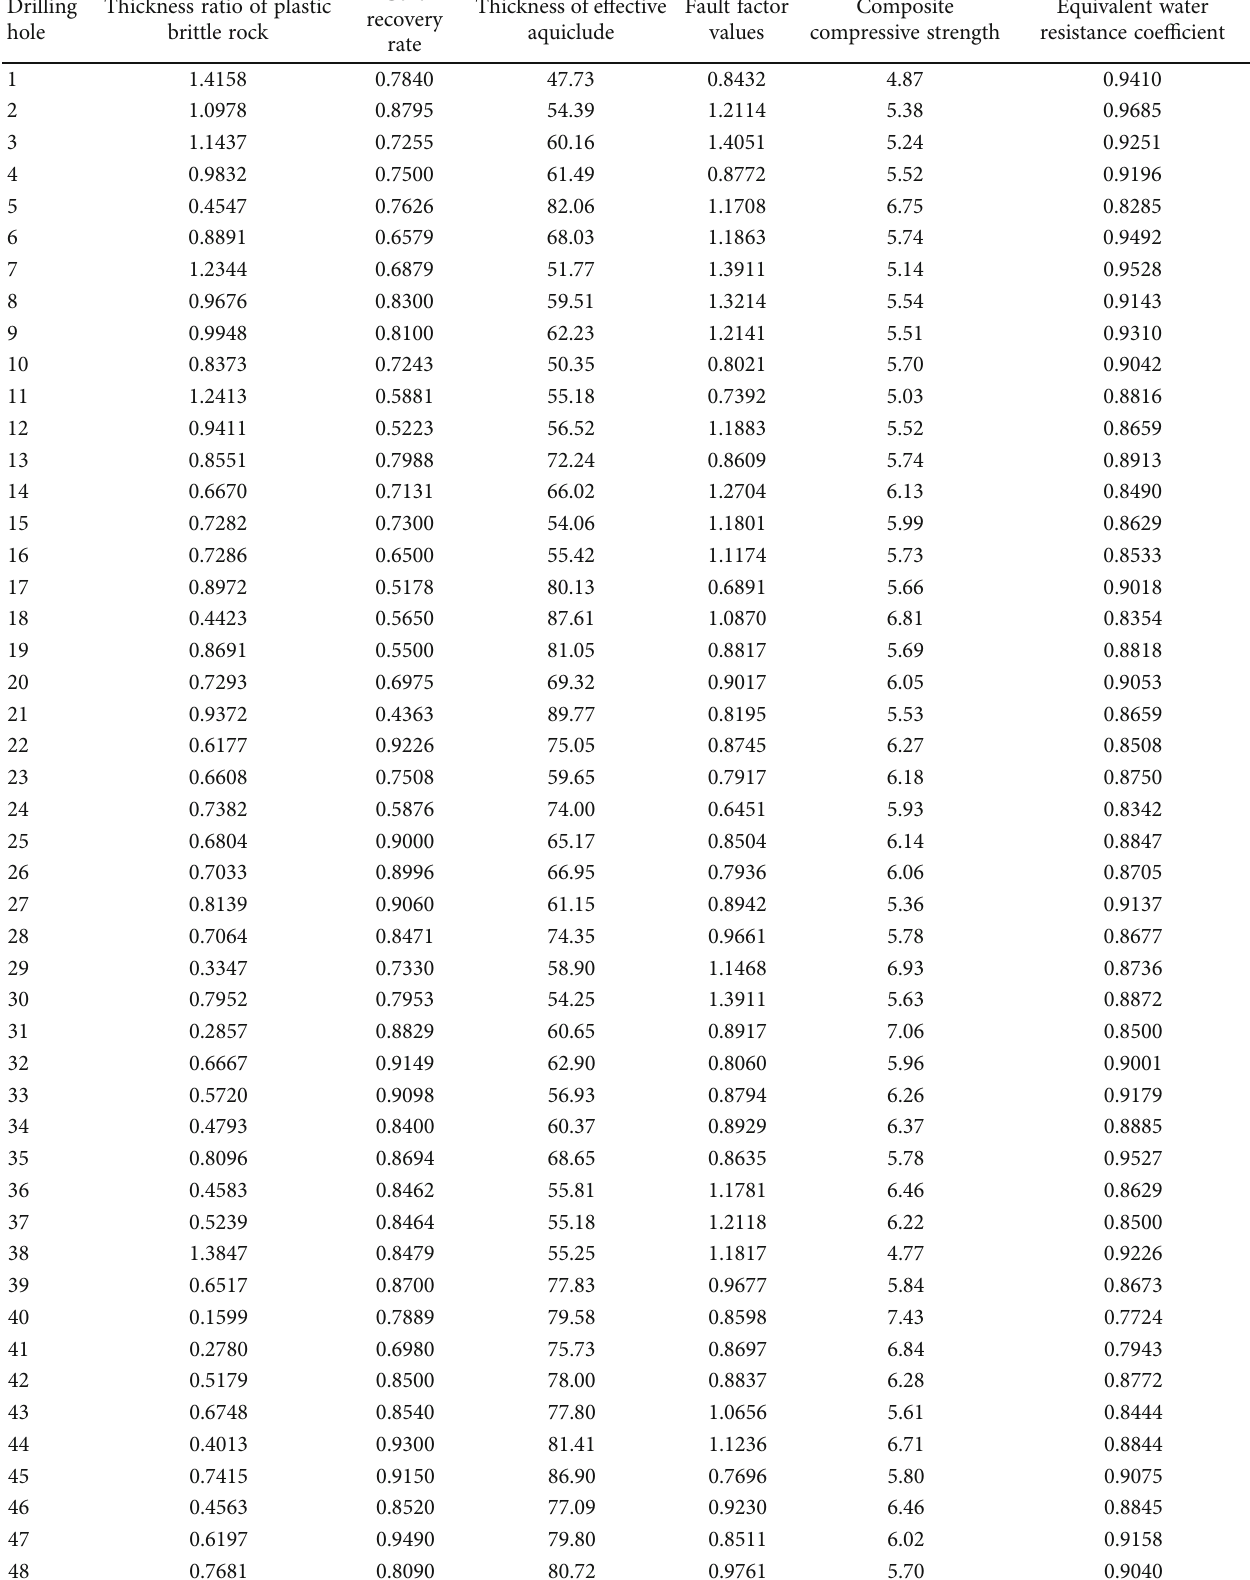
Table 2: Quantitative values of the index